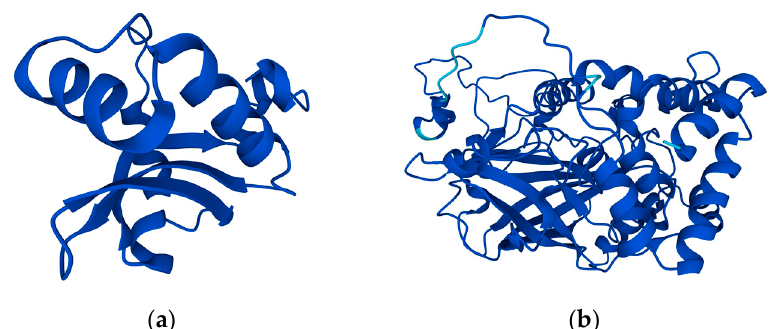
Figure 6. Schematic representation of antioxidant proteins in carp: ( a ) Q8JFG7; ( b ) E2CWE8.